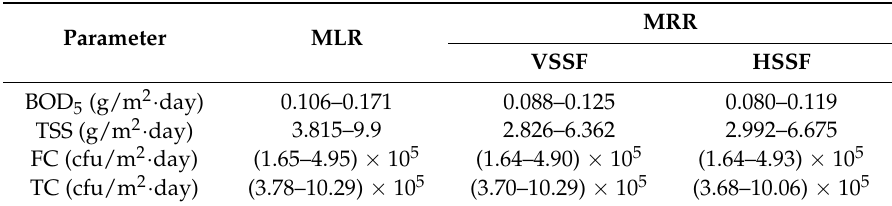
Table 3. Mass loading rates (MLRs) and mass removal rates (MRRs) for VSSF and HSSF wetland units polishing stream water.